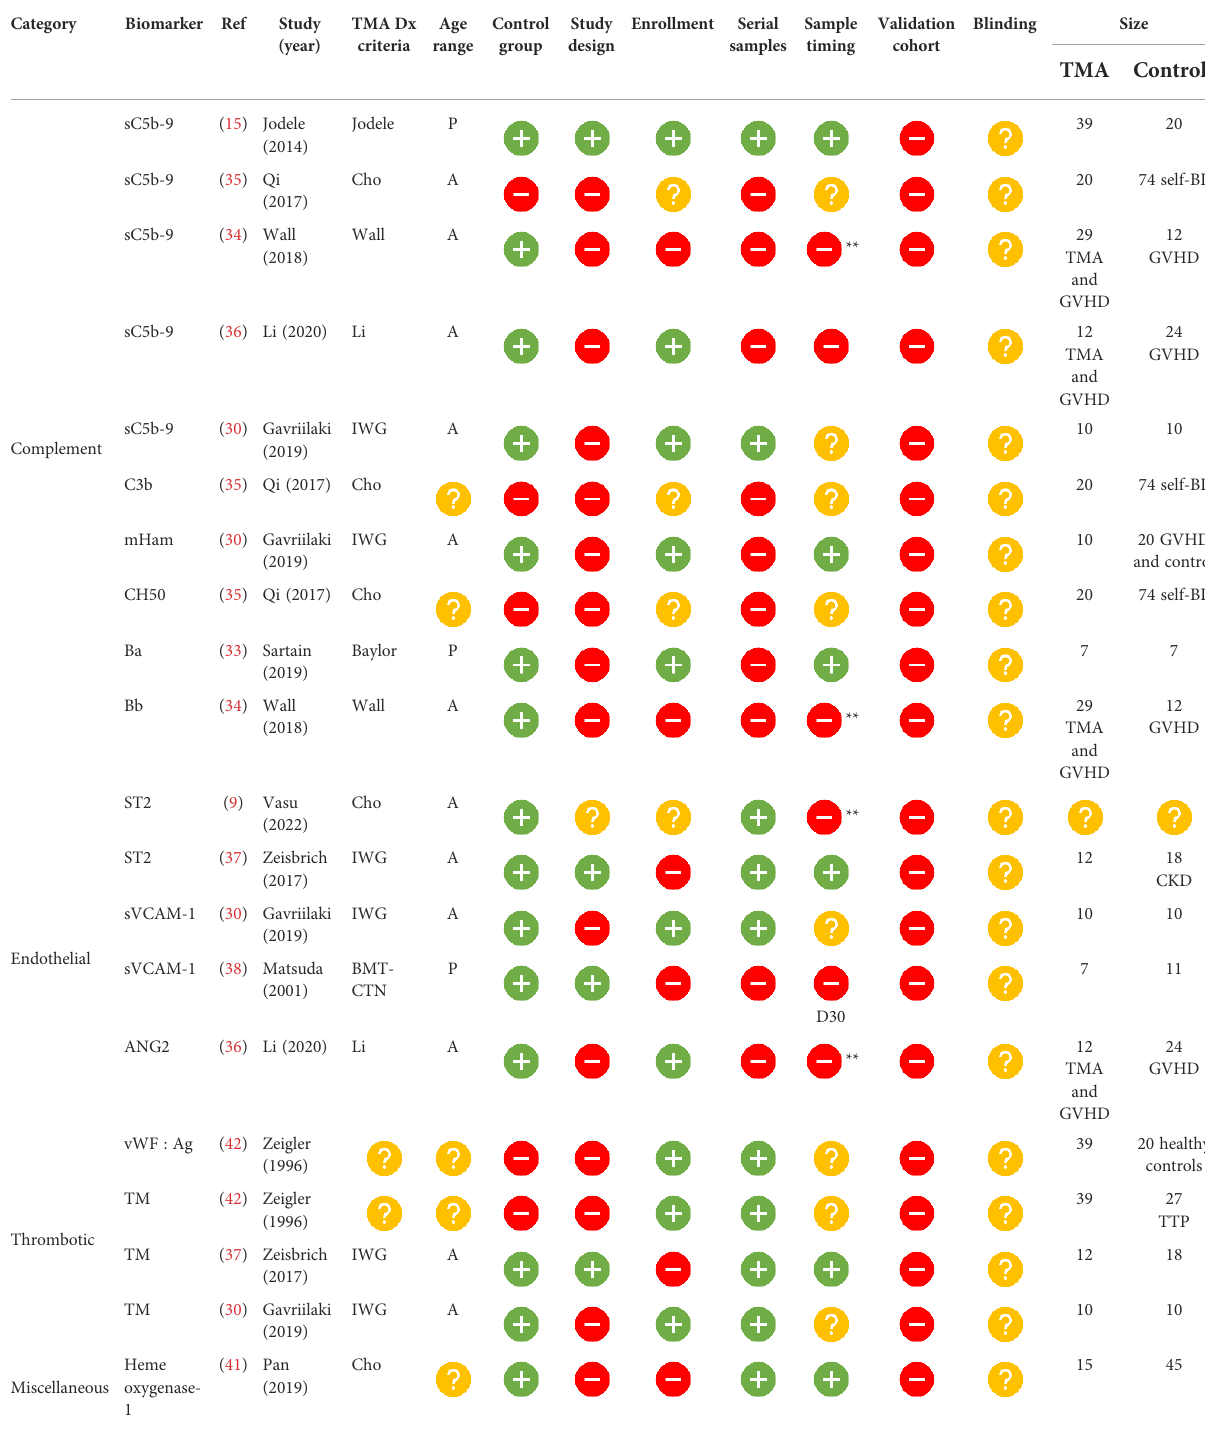
TABLE 3 b -group diagnostic